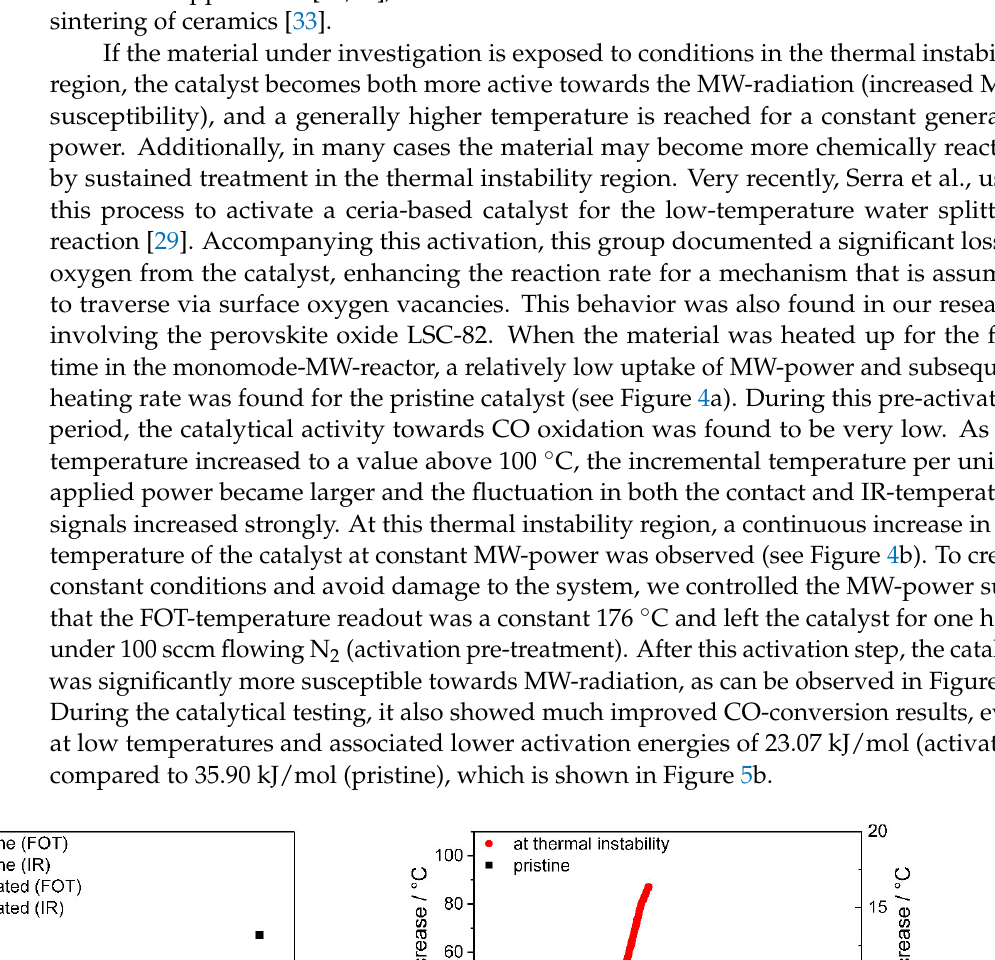
( b ) Figure 5. ( a ) CO oxidation over an LSC ‐ 82 catalyst under MW ‐ heating before (pristine) and after (activated) a sustained activation treatment under thermal instability conditions. ( b ) The same data represented as Arrhenius plot. It has to be noted that this step change in properties was not associated with a de ‐ composition of the material, as both XRD analyses and SEM investigation could not reveal any material differences in the sample’s composition or particle size before and after the MW ‐ activation (see Figure 6a,b).